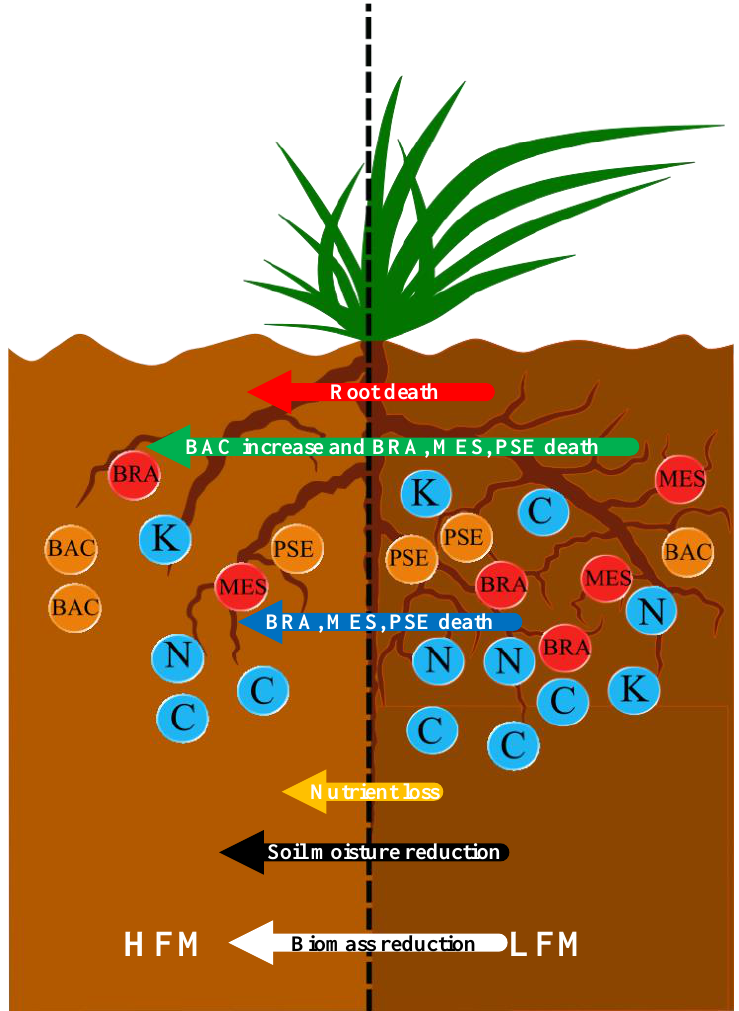
Figure 9. The direct and indirect effects of the FTCM on alpine vegetation. The white arrows indicate the total impact of the transition from the LFM to the HFM on soil vegetation; the arrows of different colors (except white) indicate the different ways in which the FTCM affects alpine vegetation. The colors of the arrows correspond to the colors of the lines in Figure 1. The same color indicates the same direction. The lines in Figure 1 are conceptual, while the arrows in Figure 8 are conclusions based on results.